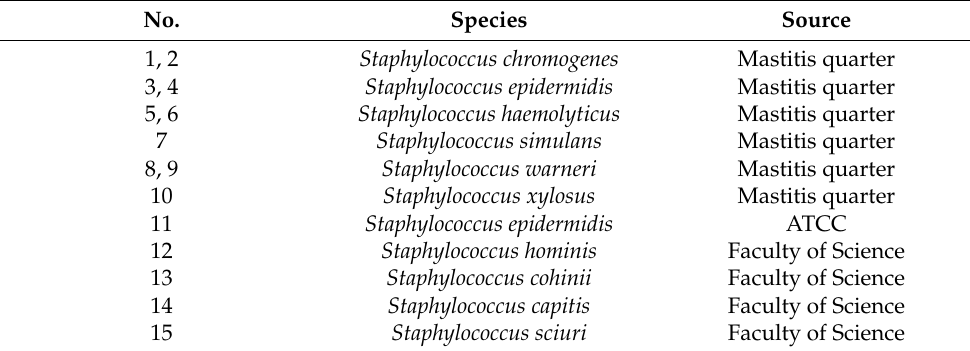
Table 1. Source of coagulase-negative staphylococci (CNS) as minor mastitis pathogens used in Experiment